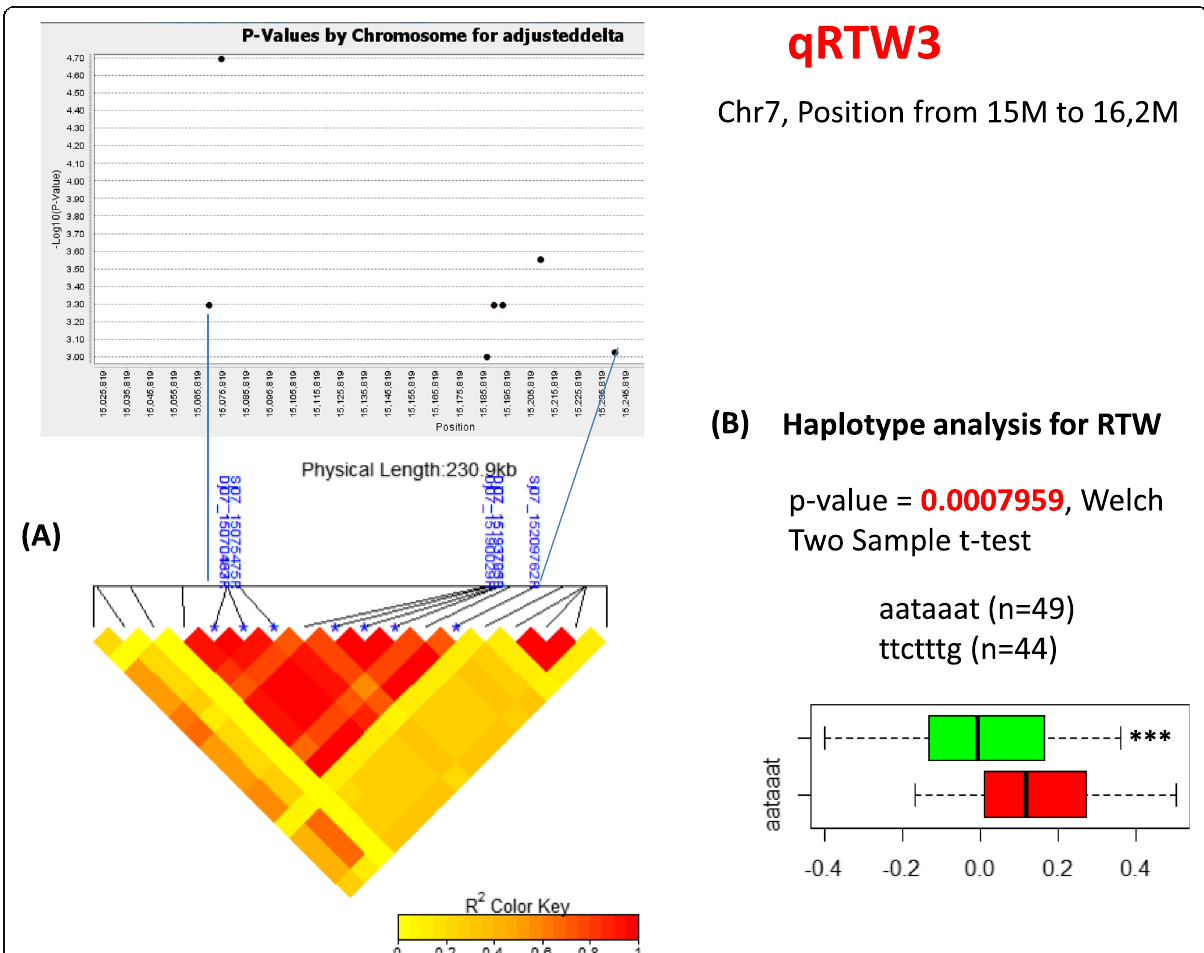
Fig. 8 Haplotype analysis for qRTW3 a Linkage Disequilibrium heatmap in the peak region of association analysis GWAS for qRTW3. Significant SNP indicated as blue star in the photo and the pattern pairwise r 2 of the associated SNPs in the QTL indicated with color code. Red color means SNPs are strongly associated to each other and yellow color means no association. The Linkage Disequilibrium heat map was created using the “ LDheatmap ” package in R. b Effect of allelic combination of 2 main haplotypes of each QTL on the value of interested traits. Number of accessions for each haplotype is indicated as (n). Welch Two Sample t-test was used to assess the differences between two haplotypes.*, **, *** indicated significant difference at p value <0.05, 0.01 and 0.001